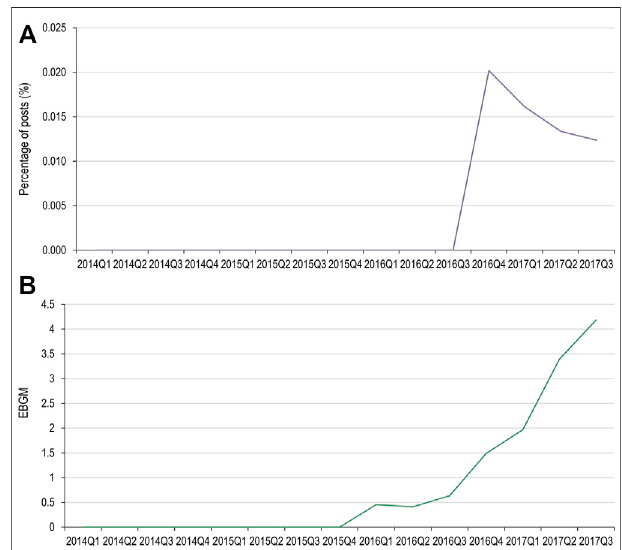
FIGURE 5 | Percentage of social media posts that mention pembrolizumaband Stevens-Johnsonsyndromeasanadverse event (A) and EBGM scores for pembrolizumab and Stevens-Johnson syndrome from FAERS data (B) FAERS, Food and Drug Administration Adverse Event Reporting System; Q, quarter; EBGM, empirical Bayes geometric